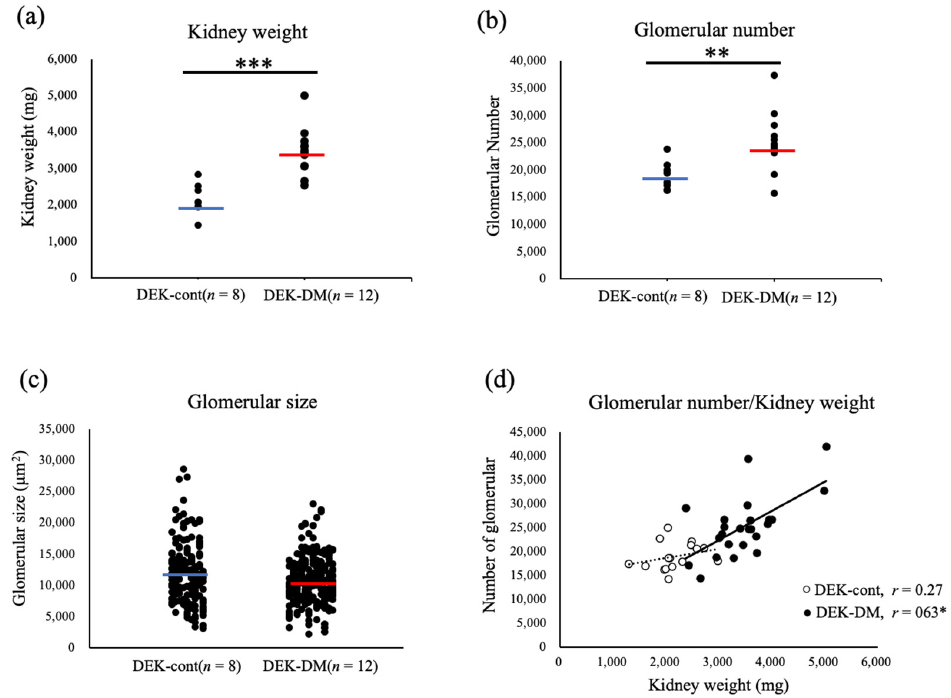
Figure 1. Analysis of glomerular number and size. Scattergrams showing mean ( a ) kidney weight and ( b ) glomerular number (GN) of individual rats. ** p < 0.01, *** p < 0.001 for between-group differences. The blue and red horizontal bars indicate averages for DEK-cont and DEK-DM rats, respectively. ( c ) Scattergram showing raw glomerular sizes ( μ m 2 ) of a total of 400 glomeruli from both kidneys of DEK-cont and DEK-DM rats. ( d ) Bilateral GN and kidney weights from individual rats plotted as white circles in DEK-cont rats and black circles in DEK-DM rats, with correlation coefficient shown as r. * p < 0.05 for correlation.